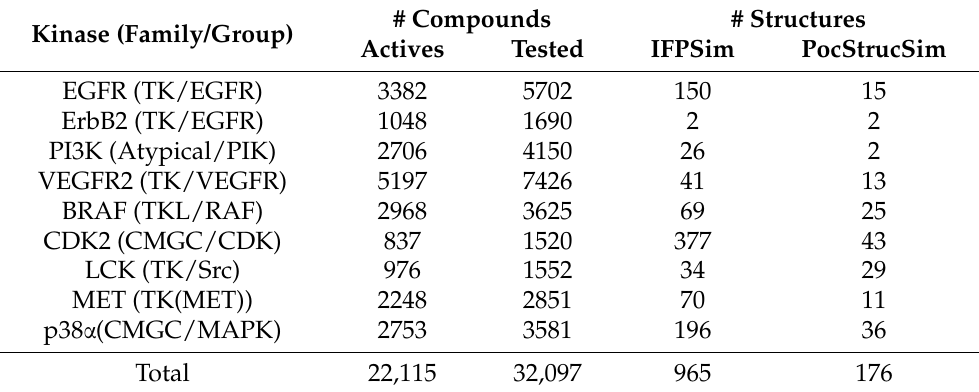
Table 5. Dataset composition for the similarity analysis. Listed are the numbers of compounds active and tested against each kinase used for the ligand profile similarity (LigProfSim), as well as number of structures used for the interaction fingerprint similarity (IFPSim) and the pocket structure similarity (PocStrucSim)